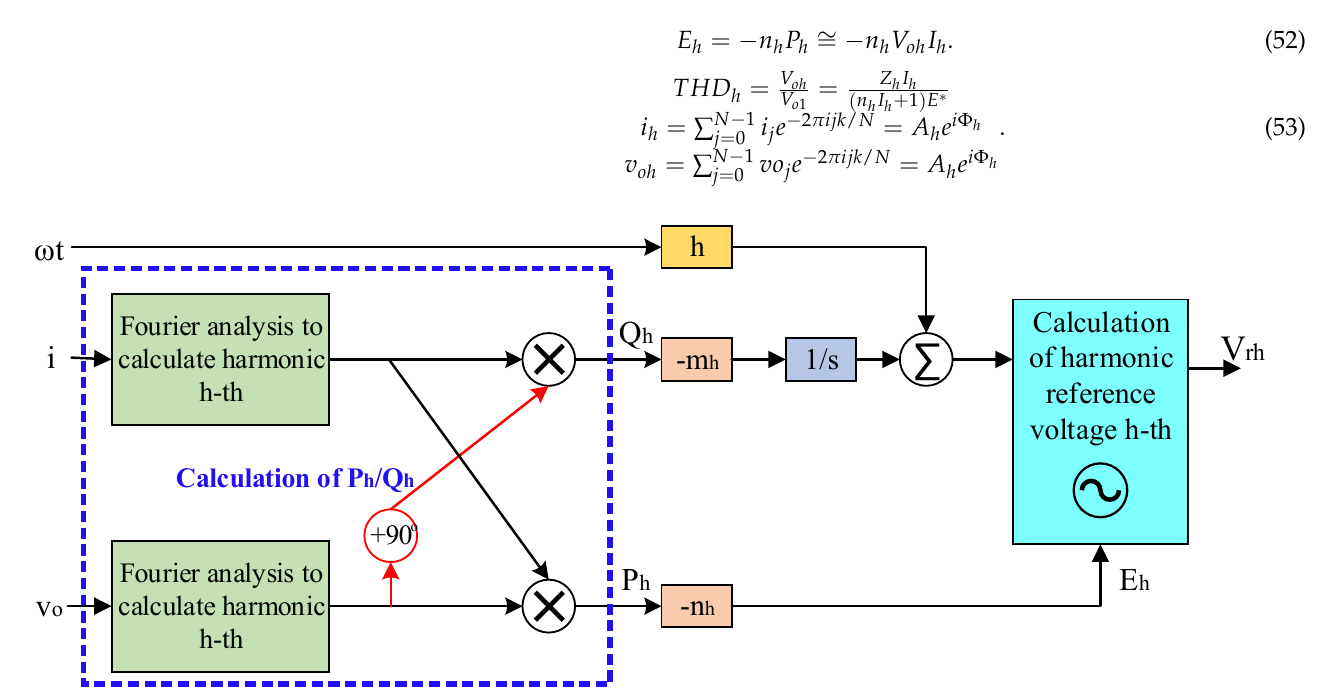
Figure 11. Proposed droop controller to reduce the h-th harmonic of the voltage. According to Equation (53), THD h has a direct relationship with the impedance of the h-th harmonic frequency, i.e., the lower the impedance at the h- th harmonic frequency, the lower the THD h at that frequency. In Figure 11, Fourier analysis is applied to the number of N inputs in the time domain based on moving windows, the output of which will be a frequency spectrum including N points with a known frequency and amplitude. As you can see in Equation (53), harmonic current and voltage can be calculated through Fourier analysis. Here, the range of frequency k can be changed between − ( N /2 − 1) and N /2. The output of this transformation is in the form of an amplitude A h and a phase Φ h